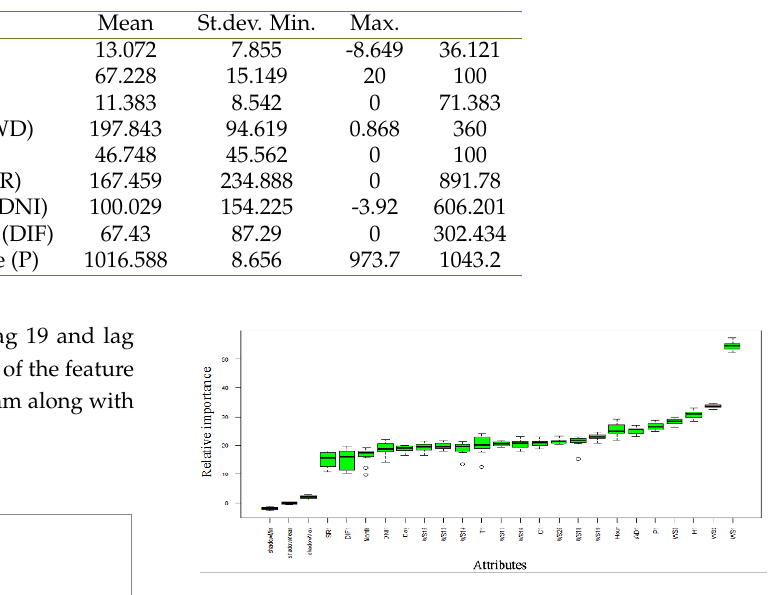
Fig. 5. The features selection’s